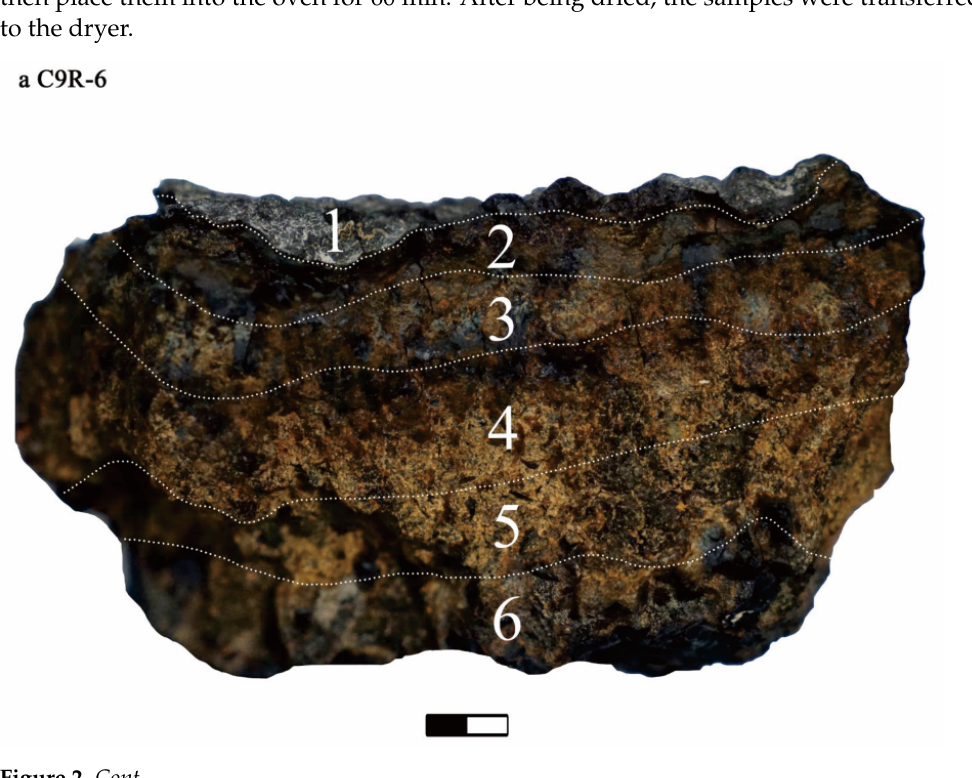
Table 1. Location of samples from Caiwei Guyot.